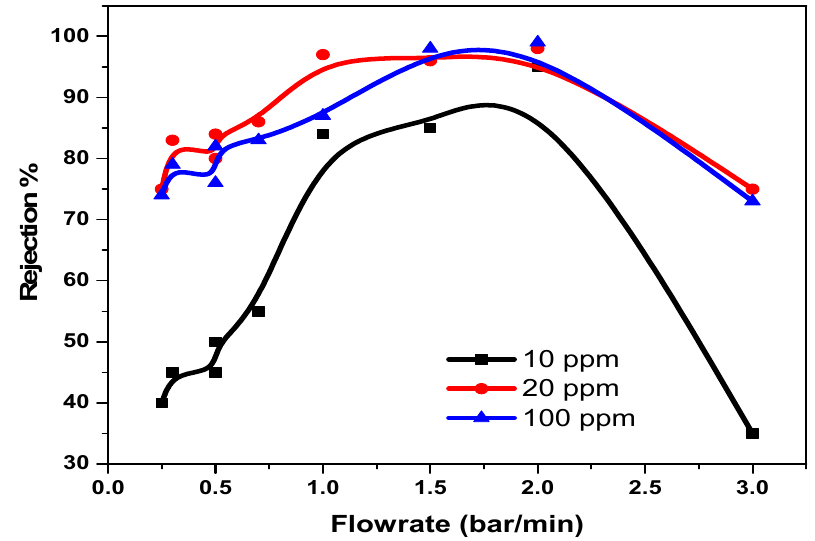
Figure 10. NF90 application on Pd 2+ on multivalent mixture at various concentration.